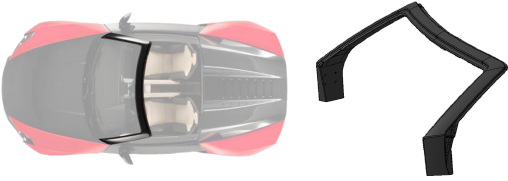
Figure 10. The demonstration example A-pillar.